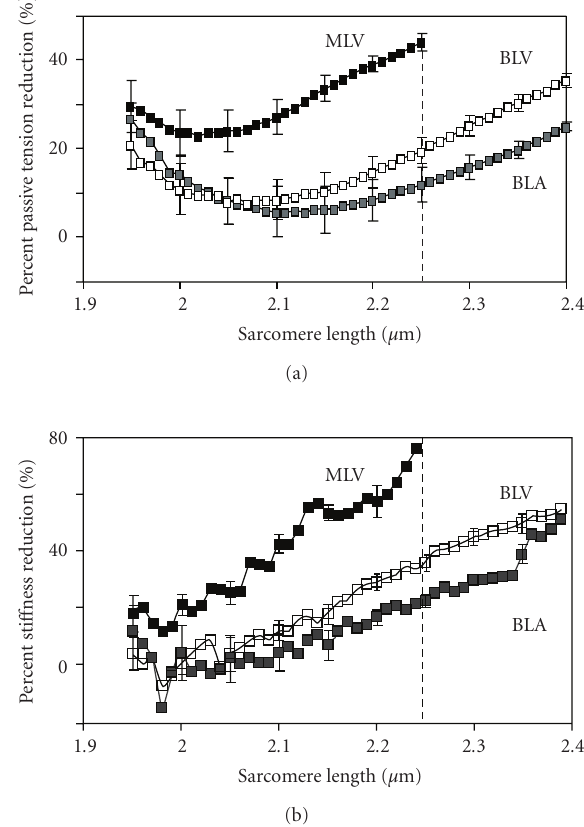
Figure 3: Reduction in titin-based tension (a) and titin-based sti ff ness (b). Data are based on measurements shown in Figure 2 (tension) and from the slope of the tension-SL curve shown in Figure 2 (sti ff ness). The reductions in tension and sti ff ness are SL dependent, in all tissue types, and are highest in MLV, lowest in BLA and intermediate in BLV. Error bars are SE (for clarity plotted only every 0.05 μ